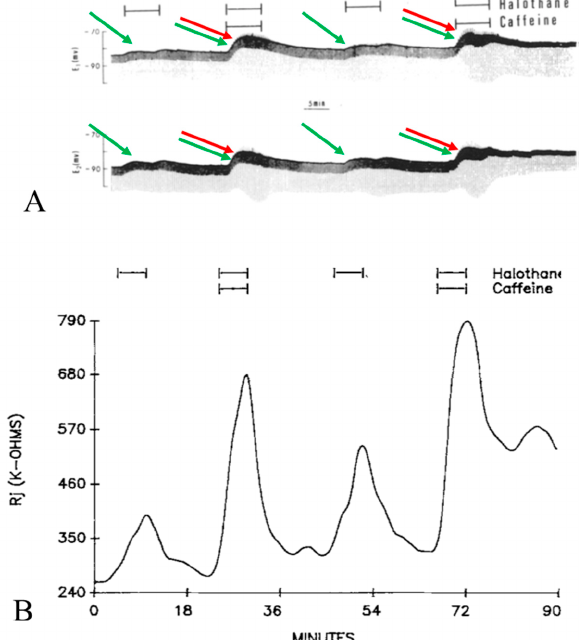
Figure 9. Time course of electrotonic potentials ( A ) and Rj ( B ) in crayfish axons uncoupled by halothane in the presence and absence of 20 mM caffeine. With halothane-caffeine, the increase in V 1 and V 2* , and the decrease in V 1* and V 2 are greater than with halothane alone ( A , red and green arrows), due to a grater increase in Rj ( B ). Note that with caffeine, there is a greater depolarization ( A , green and red arrows), whose peak corresponds to the peak or Rj maximum. Following the last halothane _ caffeine treatment, coupling recovered only partially ( A , B ). Adapted from [16] . Similar results were obtained with isoflurane (23.6 mM), which causes a 4–5 mV de- polarization (data not shown) and increases Rj by ~125% of control values (Figure 10) [16]. With addition of 20 mM caffeine to isoflurane solutions, Rj maxima are ~170% greater than those with isoflurane alone (Figure 10).